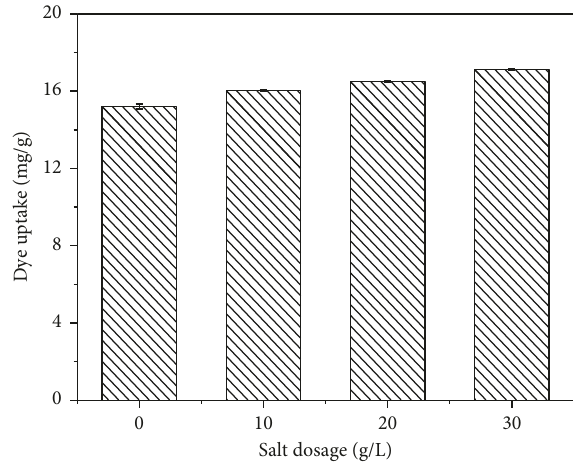
Figure 5: Effect of inorganic salt ( C time: 10h, and pH: 7).